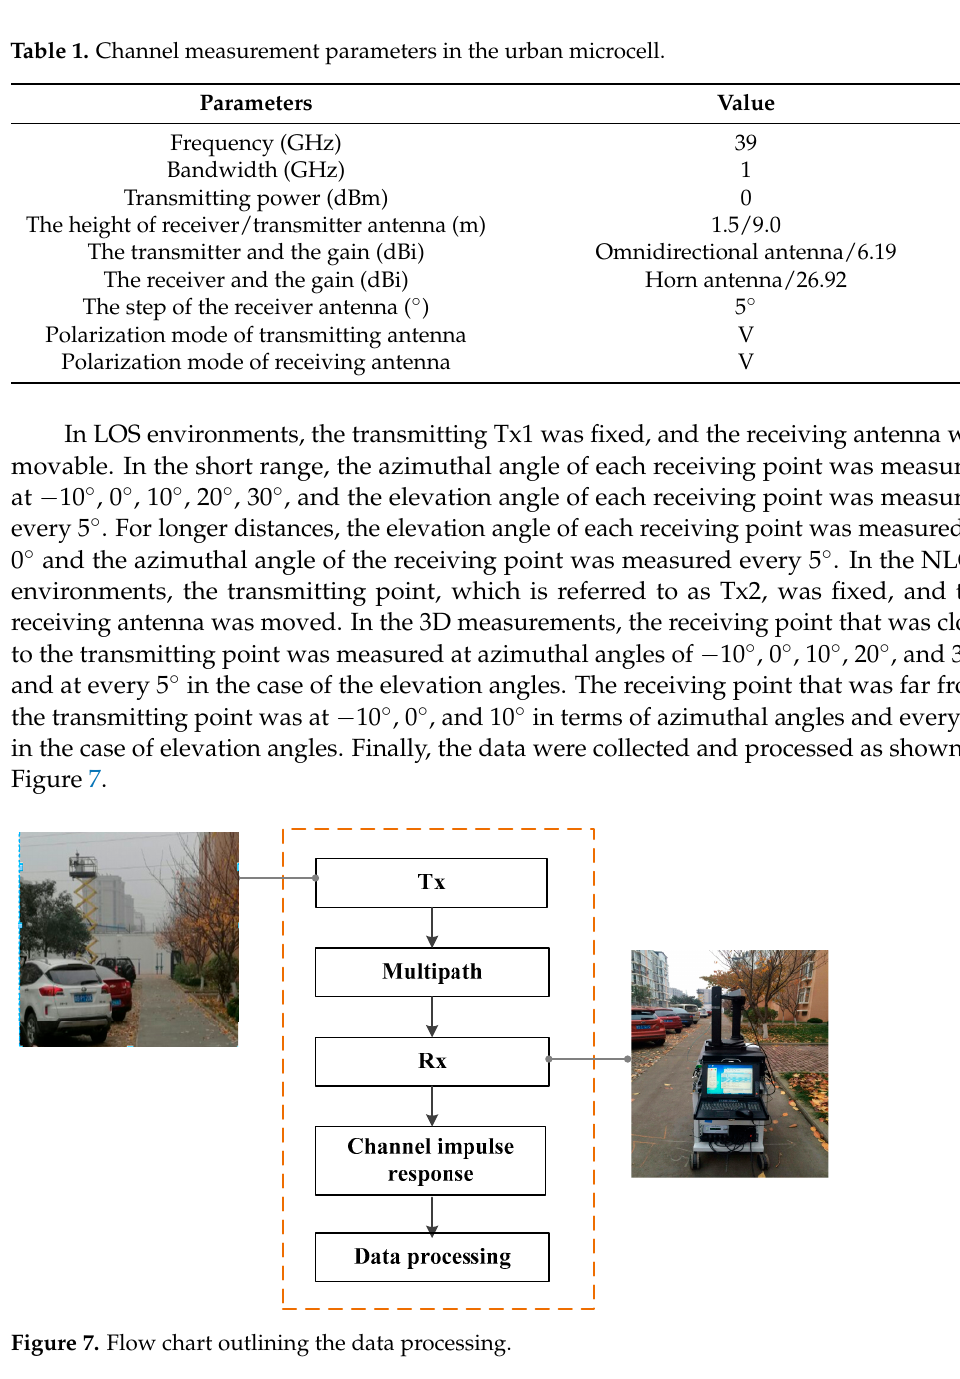
Table 1. Channel measurement parameters in the urban microcell.